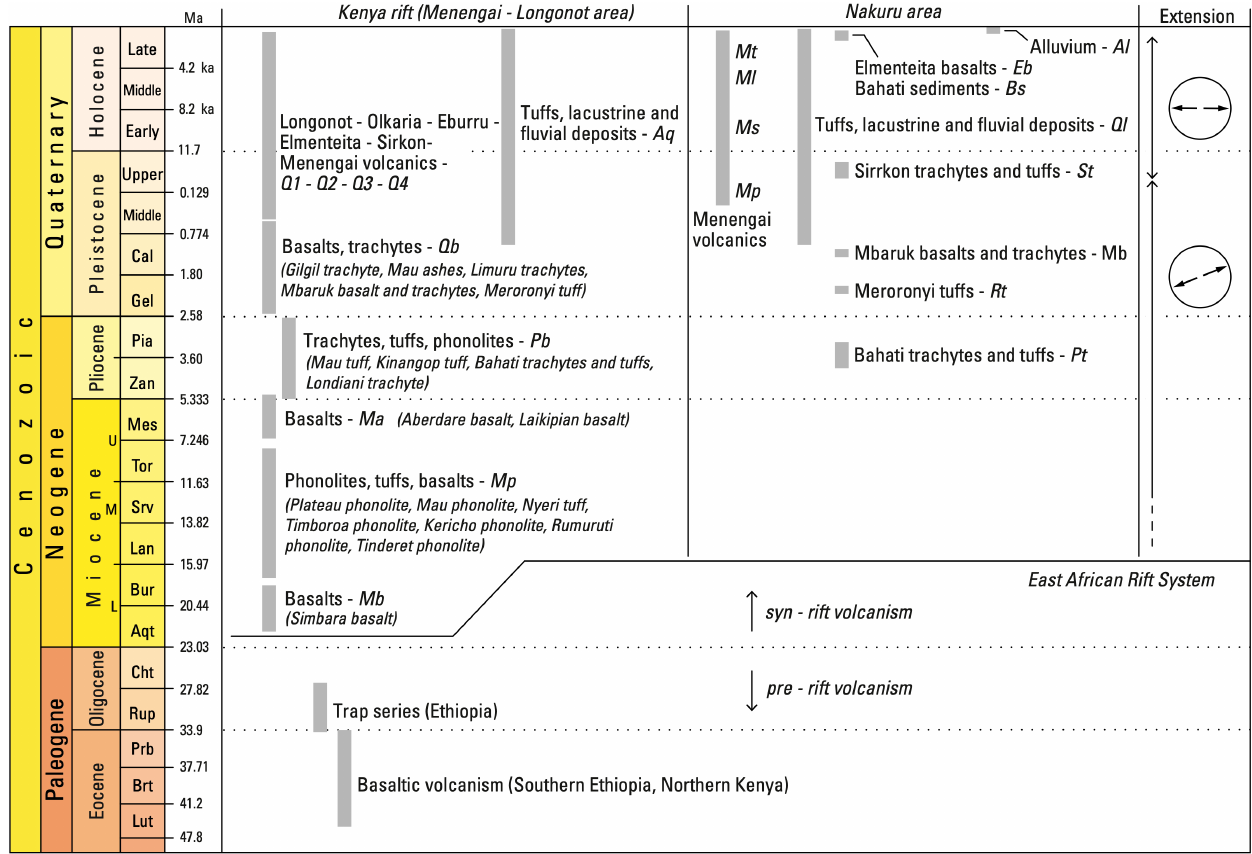
Figure 2. Schematic diagram illustrating volcanic stratigraphy in the Menengai-Longonot portion of the Kenya rift and in the Nakuru area, after Rooney [19], Baker [24], Leat [25], Roessner and Strecker [26]. Labels used in geological map of Figure 3 are indicated, in parentheses are formational names. Age of Oligocene trap series and Eocene basaltic volcanism outside of the study area are reported. Chronostratigraphic scale after Cohen et al. [27]. Extension directions are from this